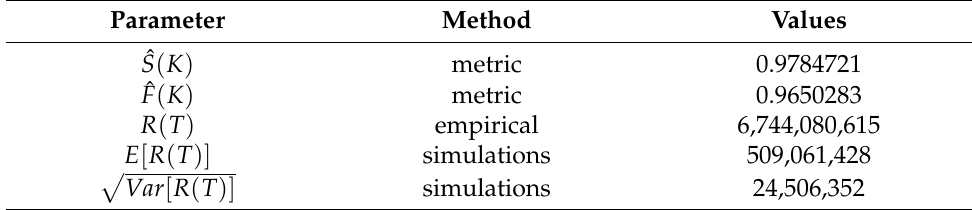
Table 8. The result of the comparison between an empirical risk process and simulations of the general compound Hawkes process at time T = 244 in Group 2.